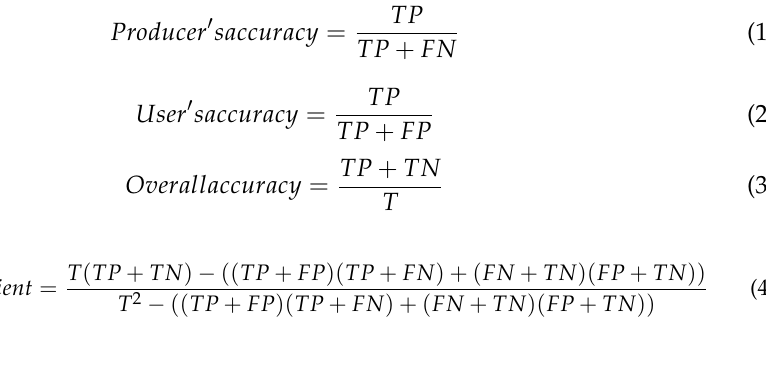
Table 4. Confusion matrix-based applied in the